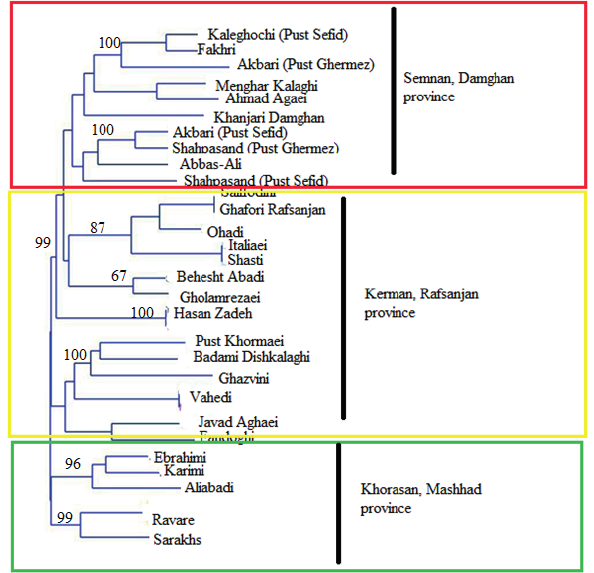
Figure 4. NJ tree of populations in Pistacia vera based on SCoT molecular